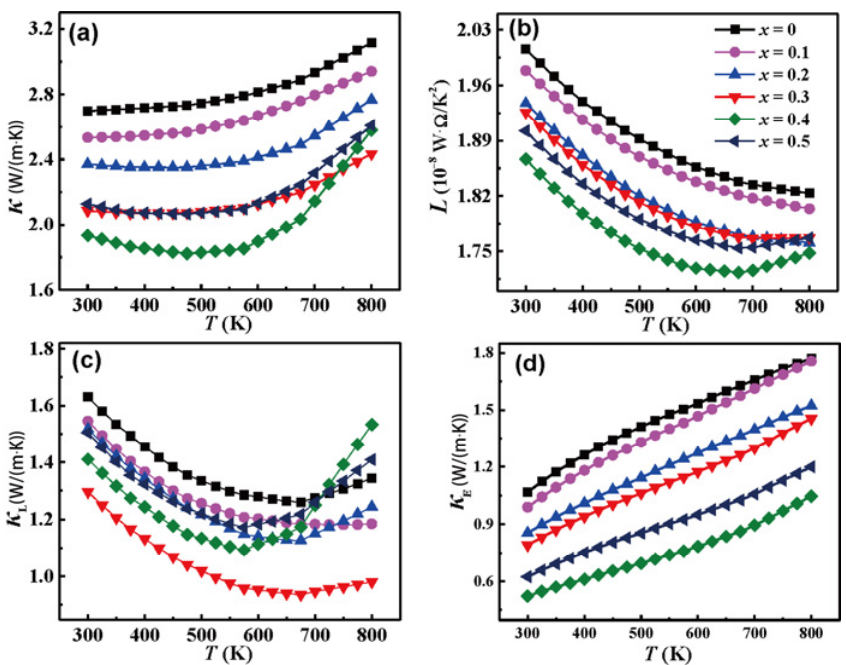
Fig. 8 Temperature dependences of (a) thermal conductivity, (b) Lorentz number, (c) lattice thermal conductivity, and (d) electrical thermal conductivity for CeFe 3.8 − x Ni x Co 0.2 Sb 12 samples at temperatures of 300–800 K.